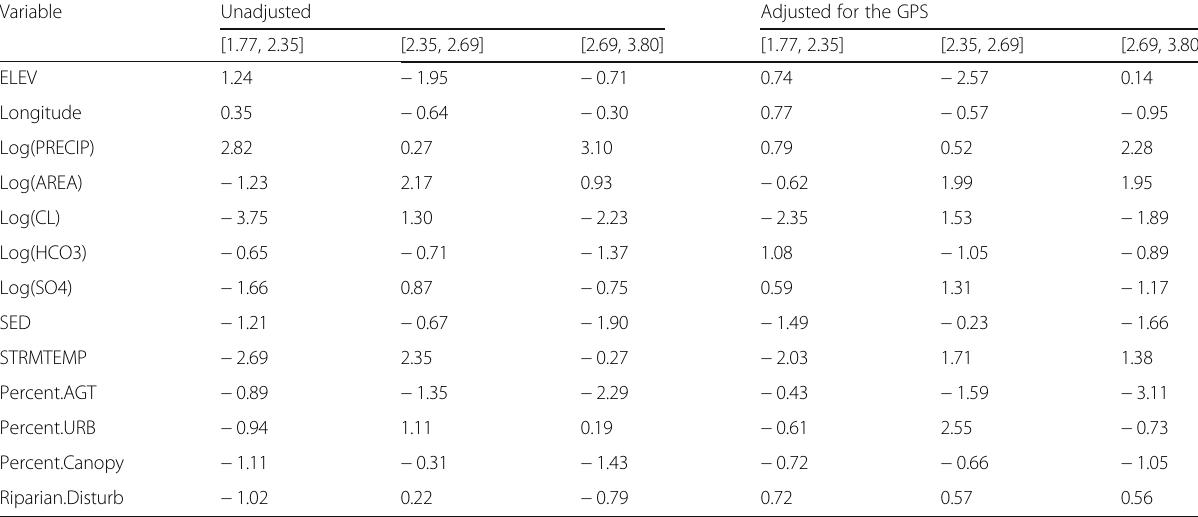
Table 6 Standardized mean differences between one group and the other two combined for the North American ecoregion Variable